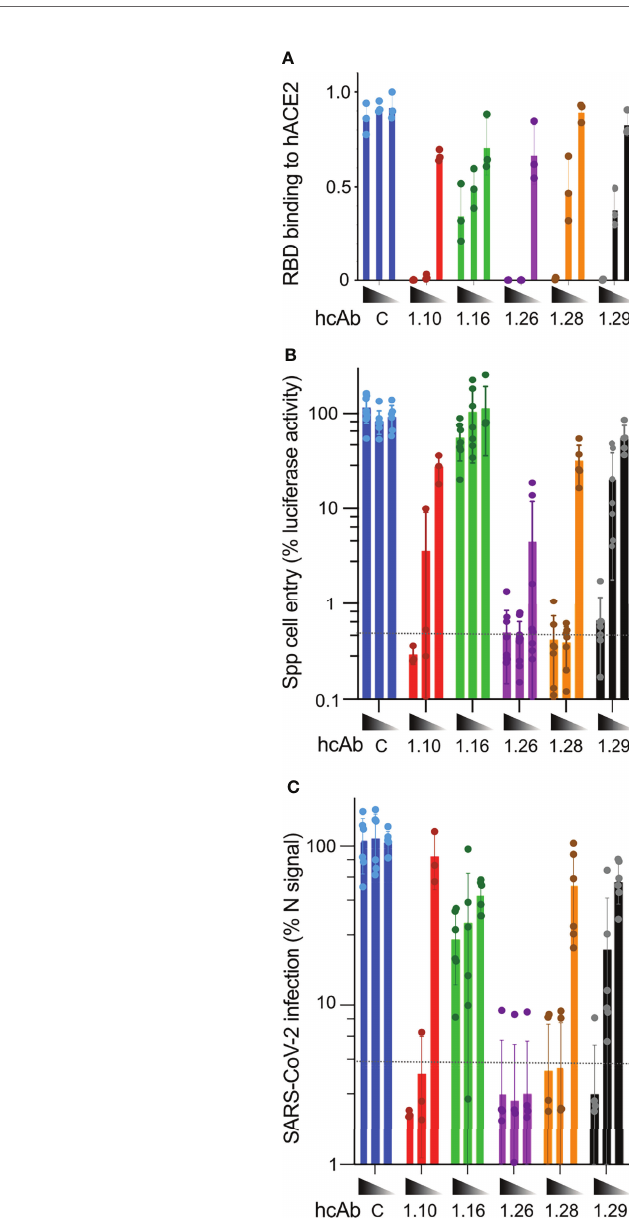
( Figure 4B ), so that they recovered from the disease. Thus, the four RBD-binding hcAbs prevented the lethality of a SARS-CoV-2 infection in K18-hACE2 mice, suggesting their therapeutic potential to reduce the risk of death by COVID-19.